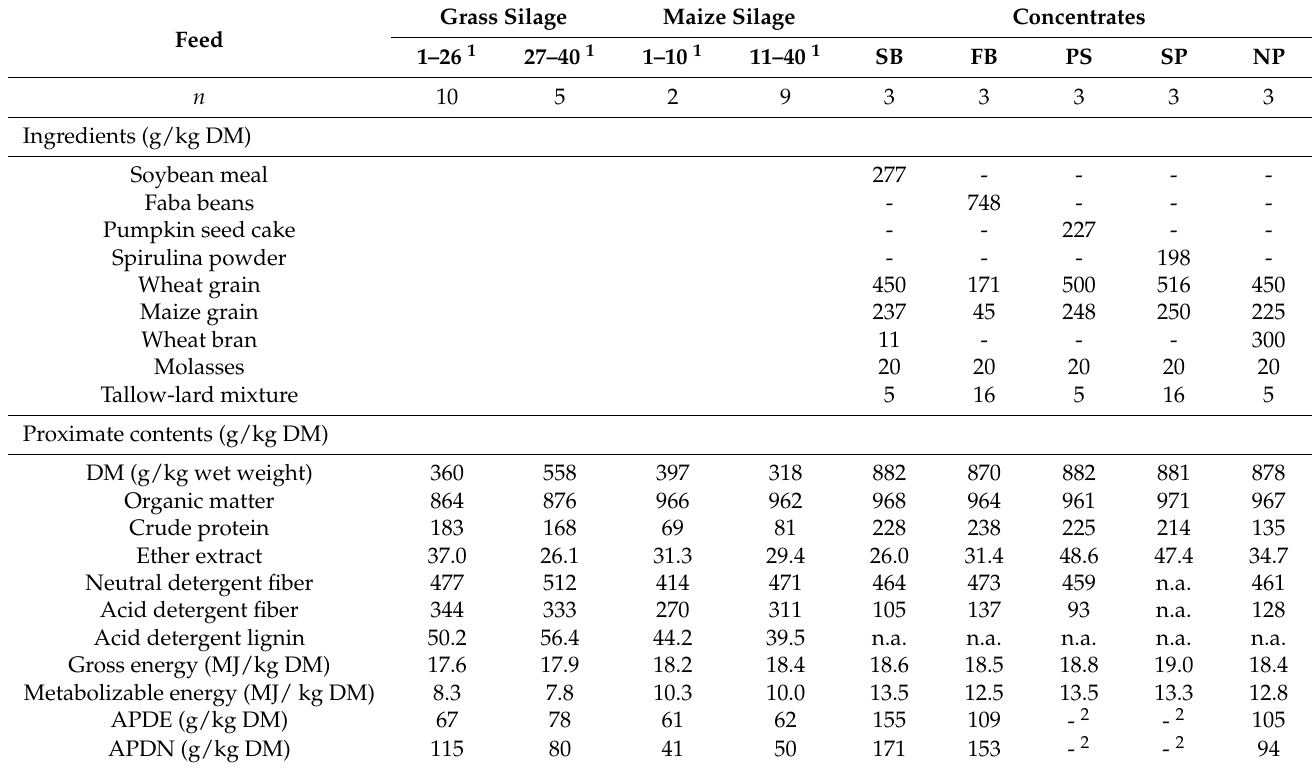
Table 2. Components of the experimental concentrates, chemical composition and selected fatty acids (FA) of concentrates and